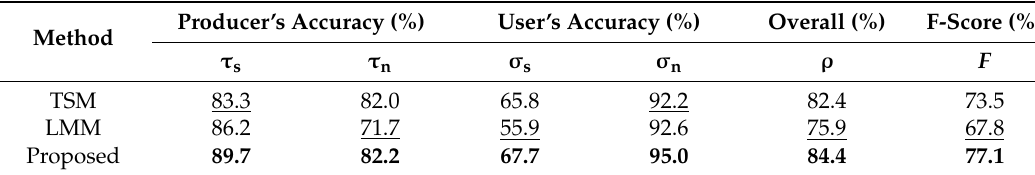
Table 3. Shadow detection accuracy measurements of test